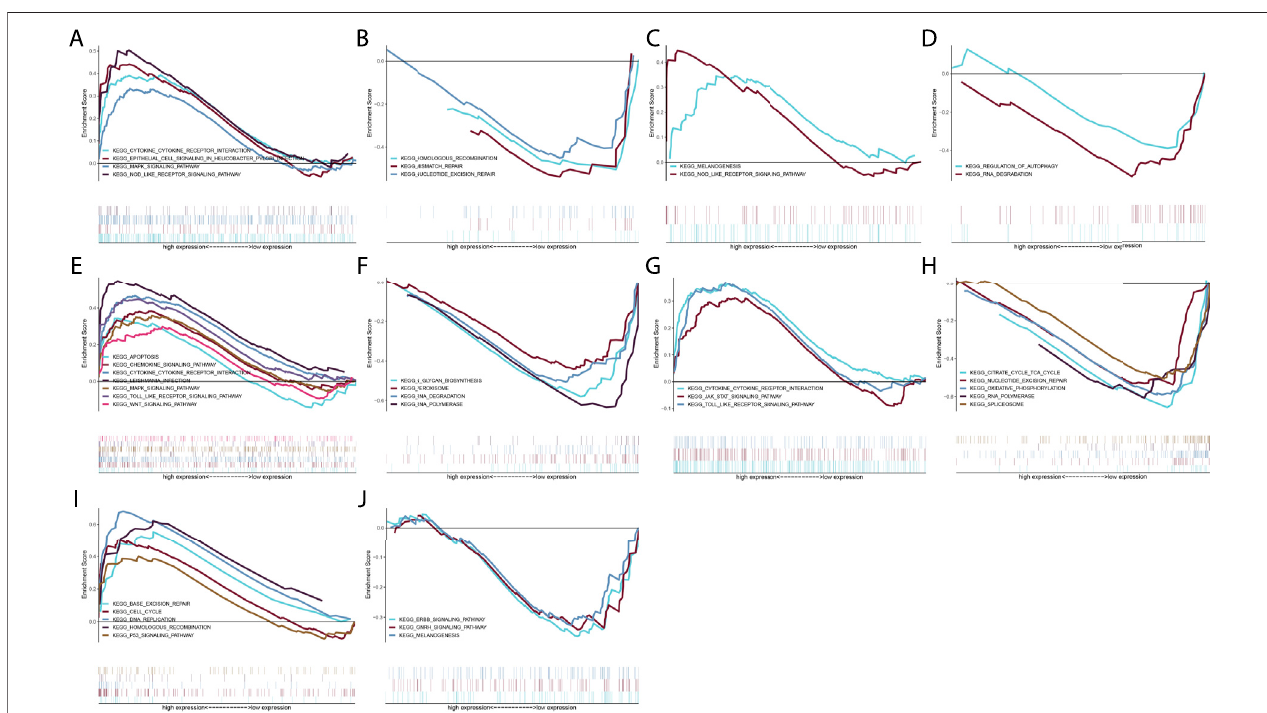
FIGURE6| Signaling pathways involvingcharacteristicgenes. (A – J) GSEA enrichmentanalysesofhigh and lowexpression ofcharacteristic genes: (A,B) CXCL1, (C,D) CXCL2, (E,F) CXCL8, (G,H) CXCR1 and (I,J) TK1 in the GSE50772